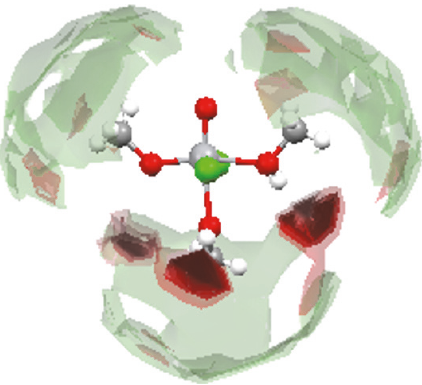
Figure 4: Full interaction map of the reference